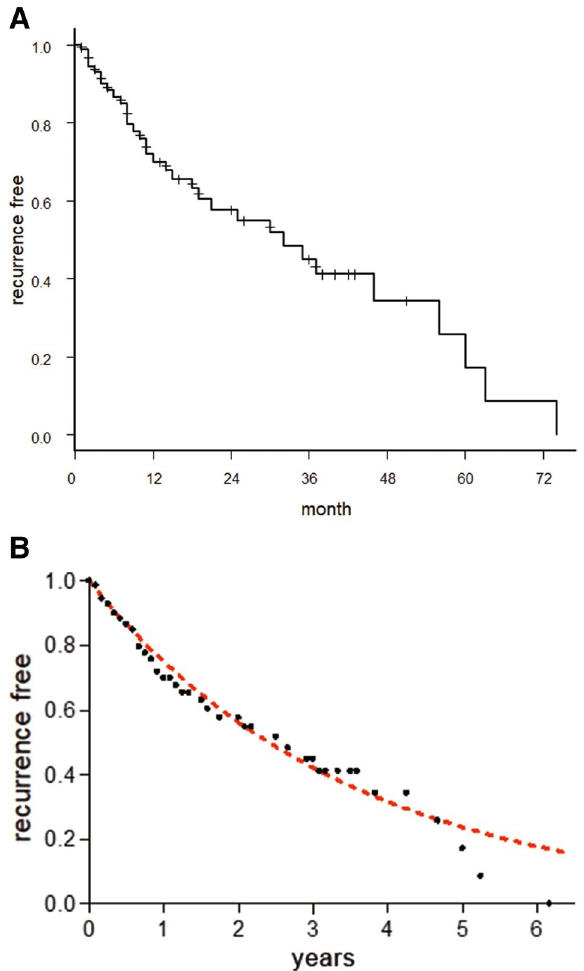
Figure 5. ( A ) Kaplan–Meier curve of recurrence data showing recurrence-free time after the first sudden sensorineural hearing loss episode. The recurrence-free (i.e., period of good hearing) rate was 69.9% over one year and 57.7% over two years; the median recurrence time for a subsequent sudden sensorineural hearing loss episode was 32 months. We used EZR ver.1.40 15 to create Kaplan–Meier curve. ( B ) Probability of recurrence over time. Logarithmic approximation (orange squares) of Kaplan–Meier graph for recurrence of sudden sensorineural hearing loss plotted along with the recurrence free rate (filled circles). The best fit value of K was .75, indicating that there is a 25% probability of sensorineural hearing loss recurrence every year. We used GraphPad Prism 9.0.0 for Windows, GraphPad Software, San Diego, California USA, www. graph pad. com to approximate the logarithmic